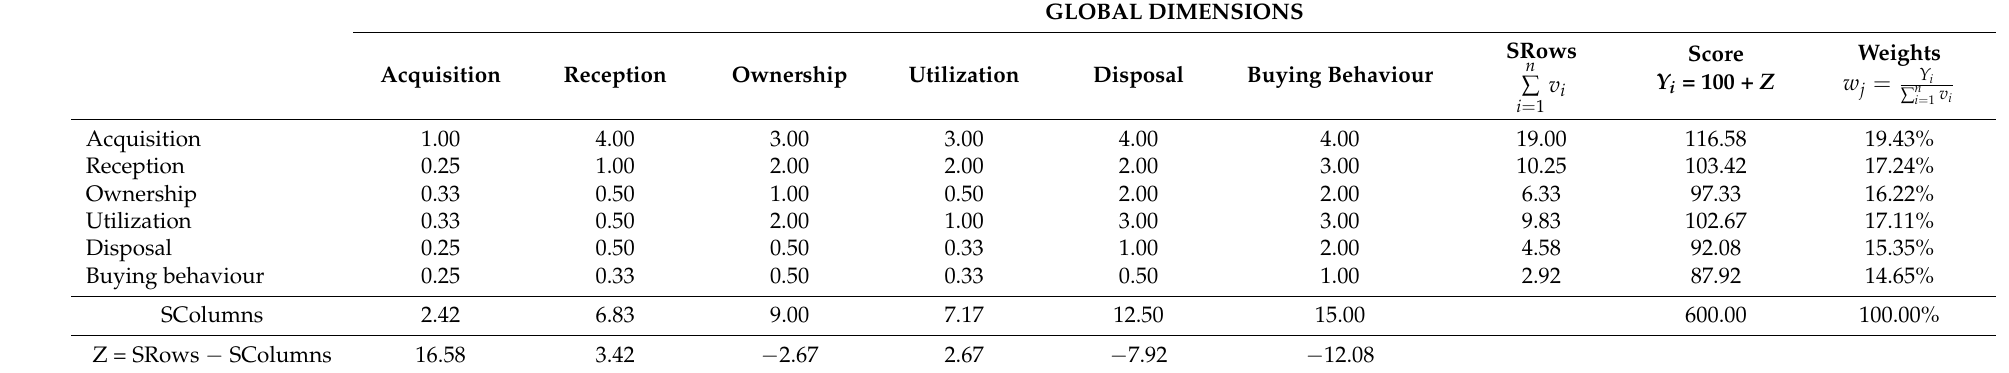
Table 9. Weights of the Dimensions (scale 1 to